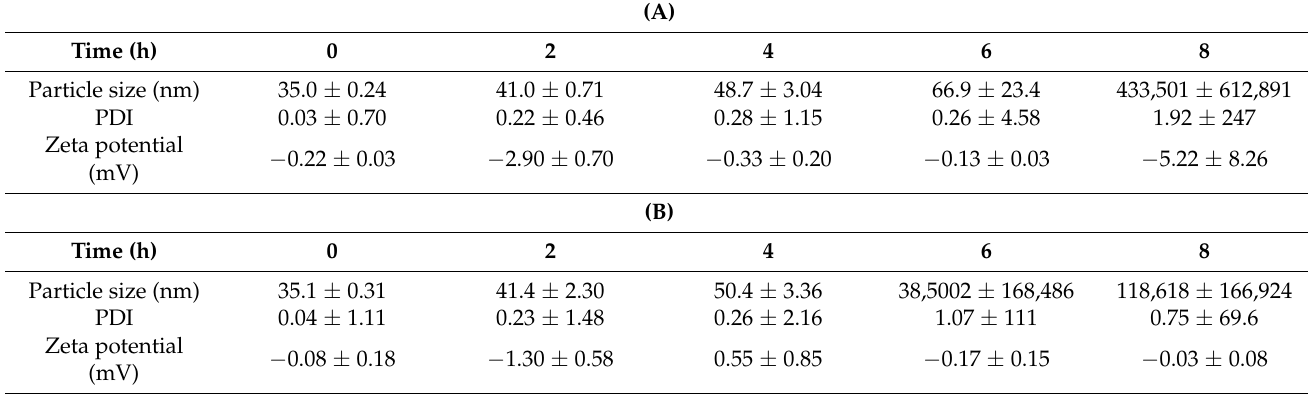
Table 3. Particle size, zeta potential, and poly-dispersity index (PDI) of paclitaxel (PTX), etoposide (ETP), and rapamycin (RAPA)-loaded mPEG-pH-PCL micelles at ( A ) a pH of 7.4 and ( B ) a pH of 5.5 (n =